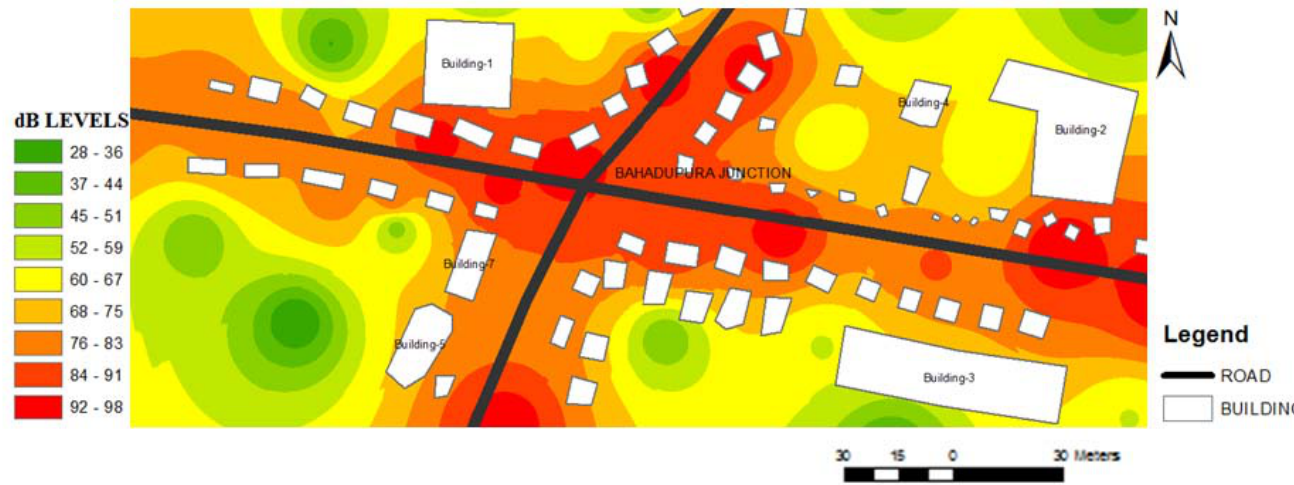
Figure 19. Long vs. short noise sampling duration based noise prediction and their difference at M5 time interval (5:00–7:00 p.m.) for the Bahadurpur study area.